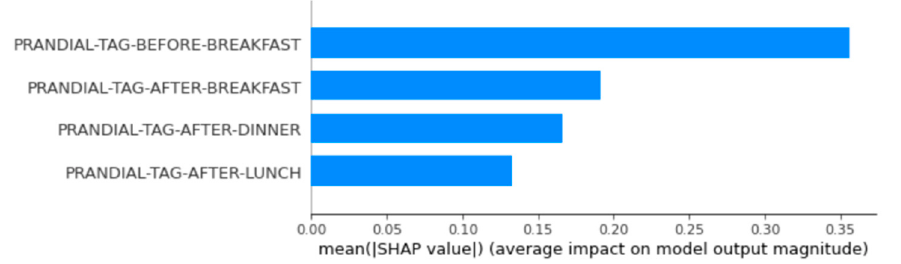
Figure A1. SHAP feature importance ranking for model trained on Tags.